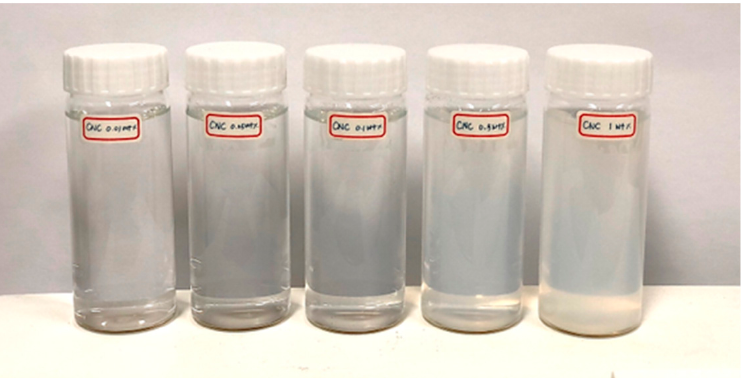
Figure 4. TEM images of the raw MWCNTs (RCNTs), alkalized MWCNTs (ACNTs), oxidized MWCNTs (OCNTs), double-oxidized MWCNTs (DOCNTs), and ground MWCNTs (GCNTs).